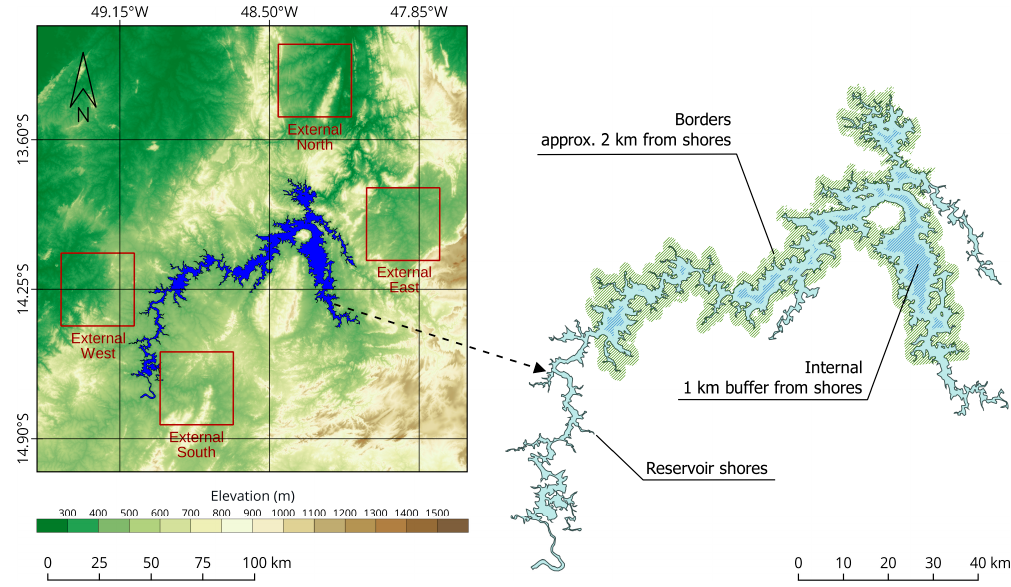
Figure 8. The topography of the region around Serra da Mesa reservoir and location of the six target areas used for cloudiness comparisons. Four external areas ( left ), the borders, and internal areas ( right ).